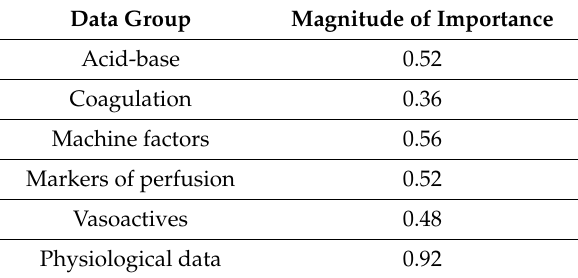
TableA2. Magnitudeofvariablegroupimportancetofinalmodelpredictionsfollowingfeaturemasking.